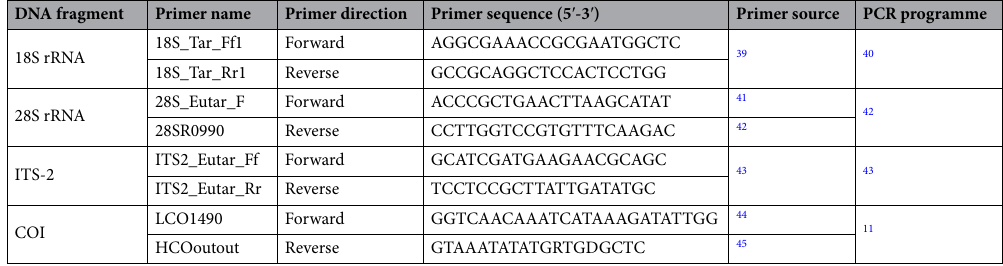
Table 2. Primers and references for specific protocols for amplification of the four DNA fragments sequenced in the